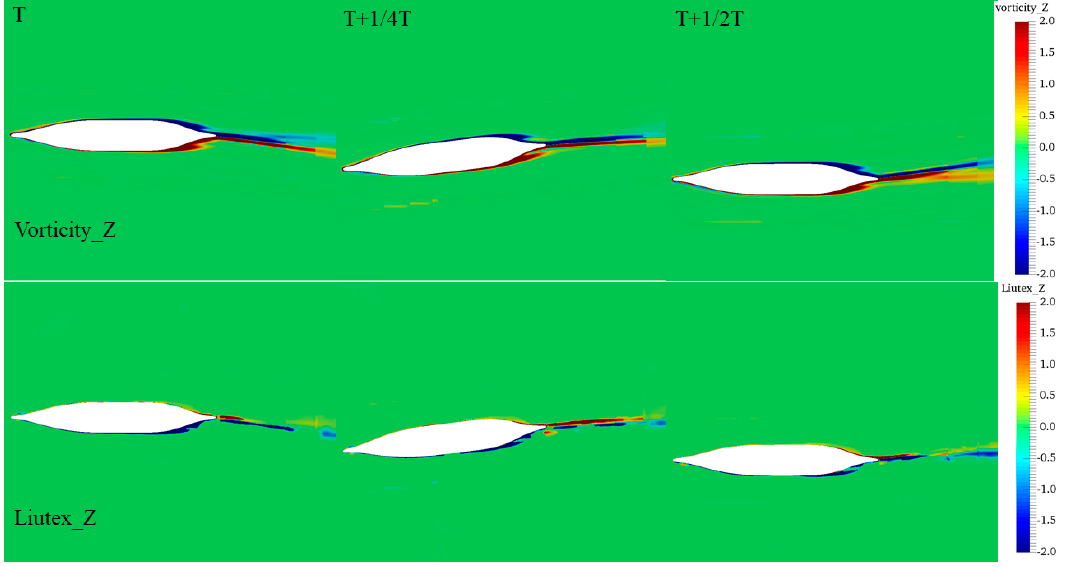
Figure 20. Vertical vorticity (top) and Liutex (bottom) at z/L pp = − 0.03572 in CASE PY16.